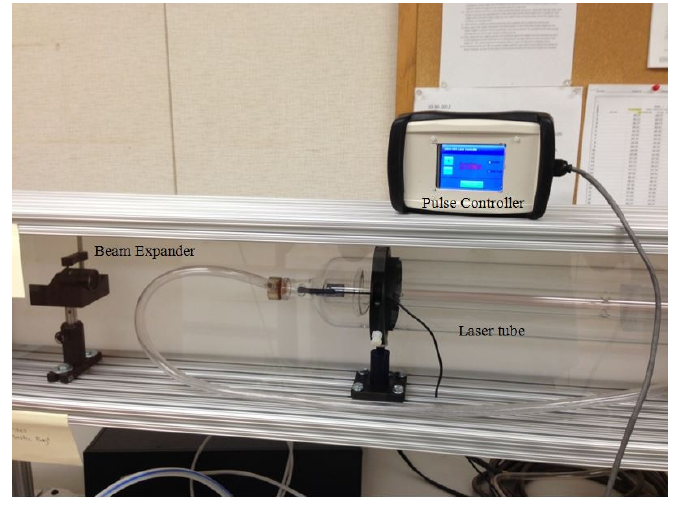
Figure 4. Experimental micro ‐ controller ‐ based computer ‐ numerical ‐ controlled (CNC) CO 2 laser treatment system designed to provide precise control over the laser treatment time and energy